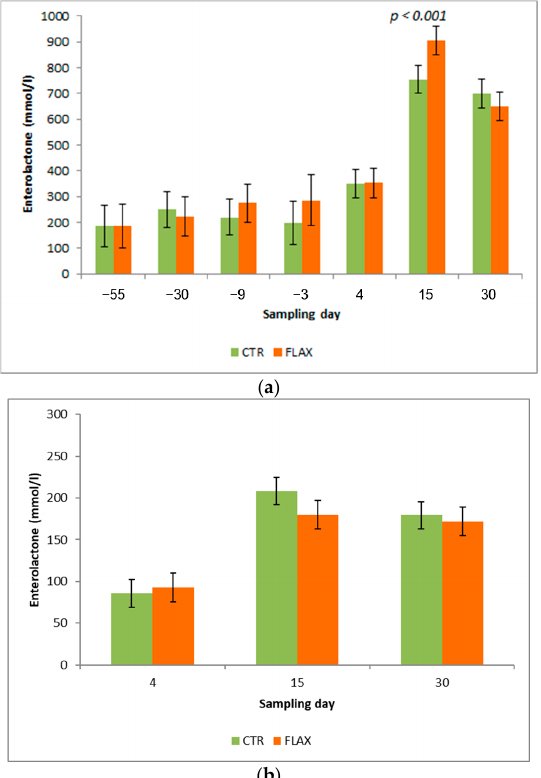
Figure 3. Concentration (nmol/L) of enterolactone in Holstein cows fed either with flacked flaxseed or a control diet during the dry period: ( a ) concentration in plasma (before and 30 d after calving); ( b ) concentration in milk during 30 d after calving. Differences between treatments within sampling day have been reported when significant ( p < 0.05).